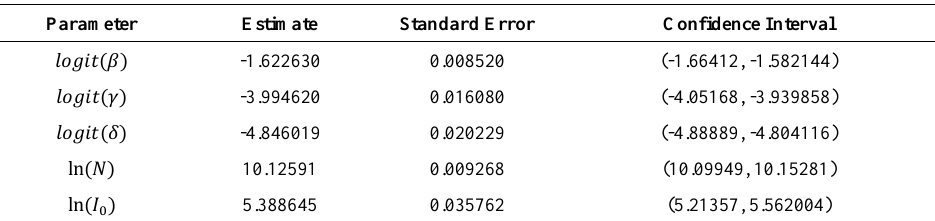
Table A29. Emilia–Romagna. Estimates, asymptotic standard errors, and 95% profile likelihood mCIs for the parameters of the SIRD model